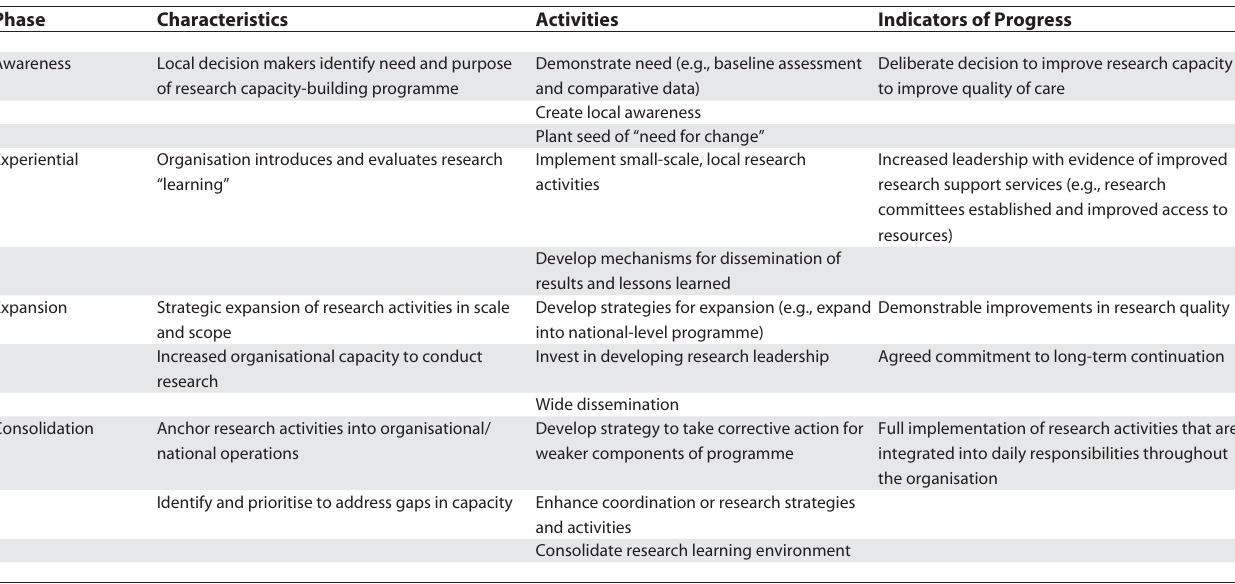
Table 1. Framework for Designing and Evaluating a Health Research Capacity-Building